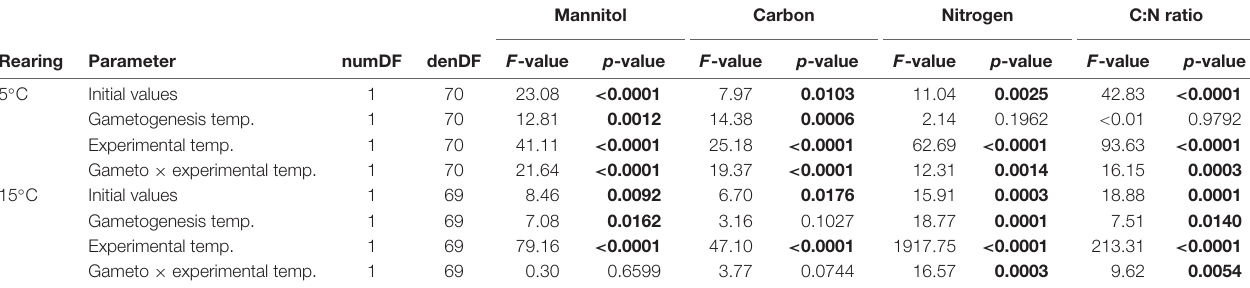
TABLE 4 | Results of linear mixed effects models to examine thermal plasticity of biochemical parameters of juvenile Laminaria digitata sporophytes in experiment 2.